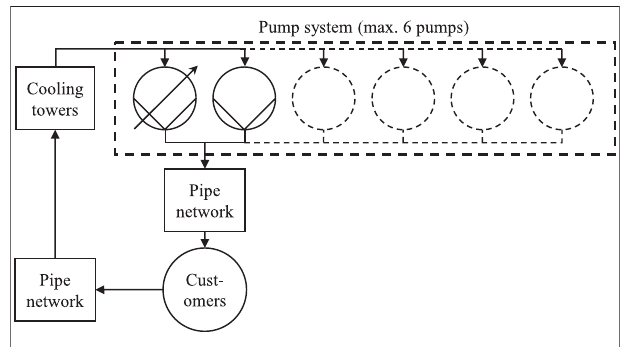
FIGURE 5 | Scheme of the industrial real-world pump system (dotted rectangle). The pump system is connected to several customers and cooling towers via a pipe network, adapted from Bahl et al.